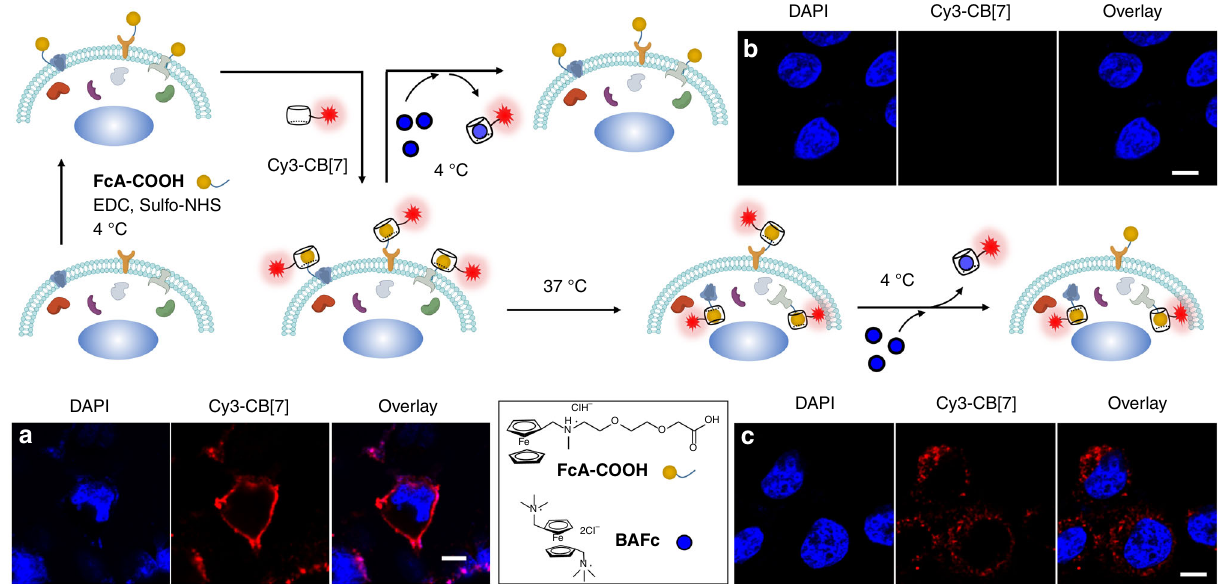
Fig. 3 Selective visualization of intracellularly translocated proteins. Schematic illustration of the ferrocenylation of plasma membrane proteins and visualization of those proteins using Cy3-CB[7] and confocal laser scanning microscope images. a COS7 cells treated with FcA-COOH , EDC, and sulfo- NHS at 4 °C for 30 min, b the cells further incubated with BAFc at 4 °C for 20 min after a , and c the cells treated with BAFc at 4 °C for 20 min after additional incubation for 1 h at 37 °C of the cells in a . Scale bar = 10 μ